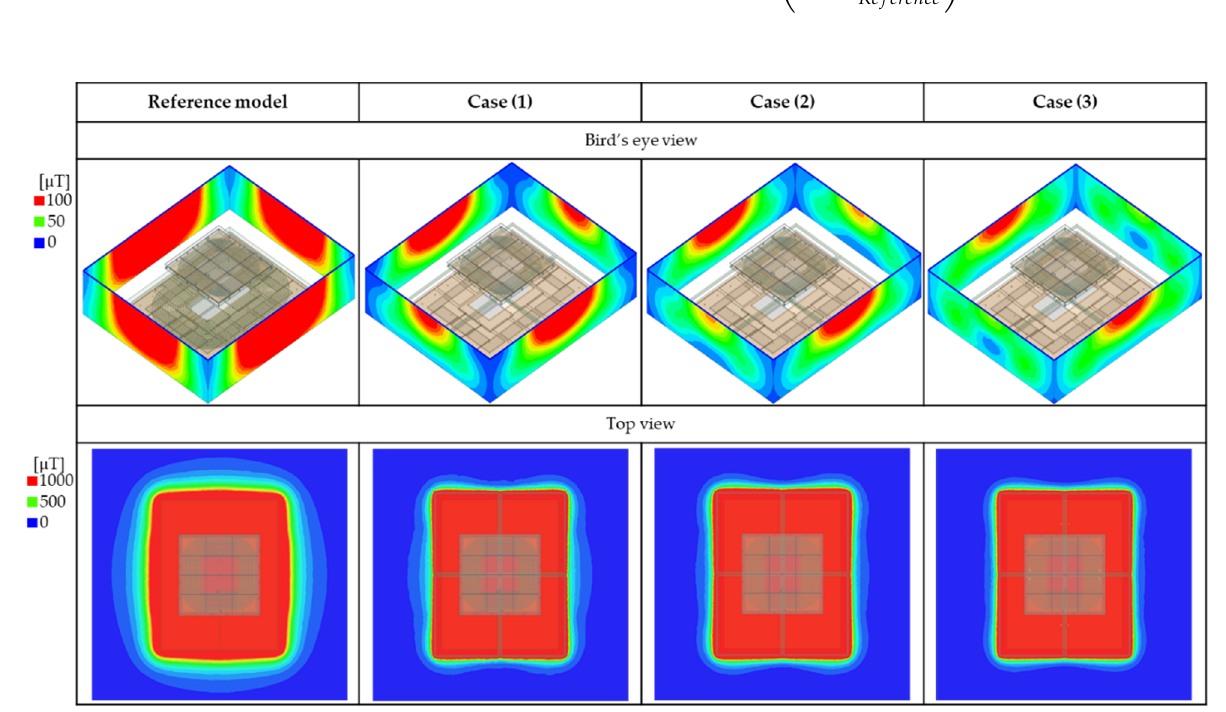
Figure 13. Comparison of the leakage magnetic field.